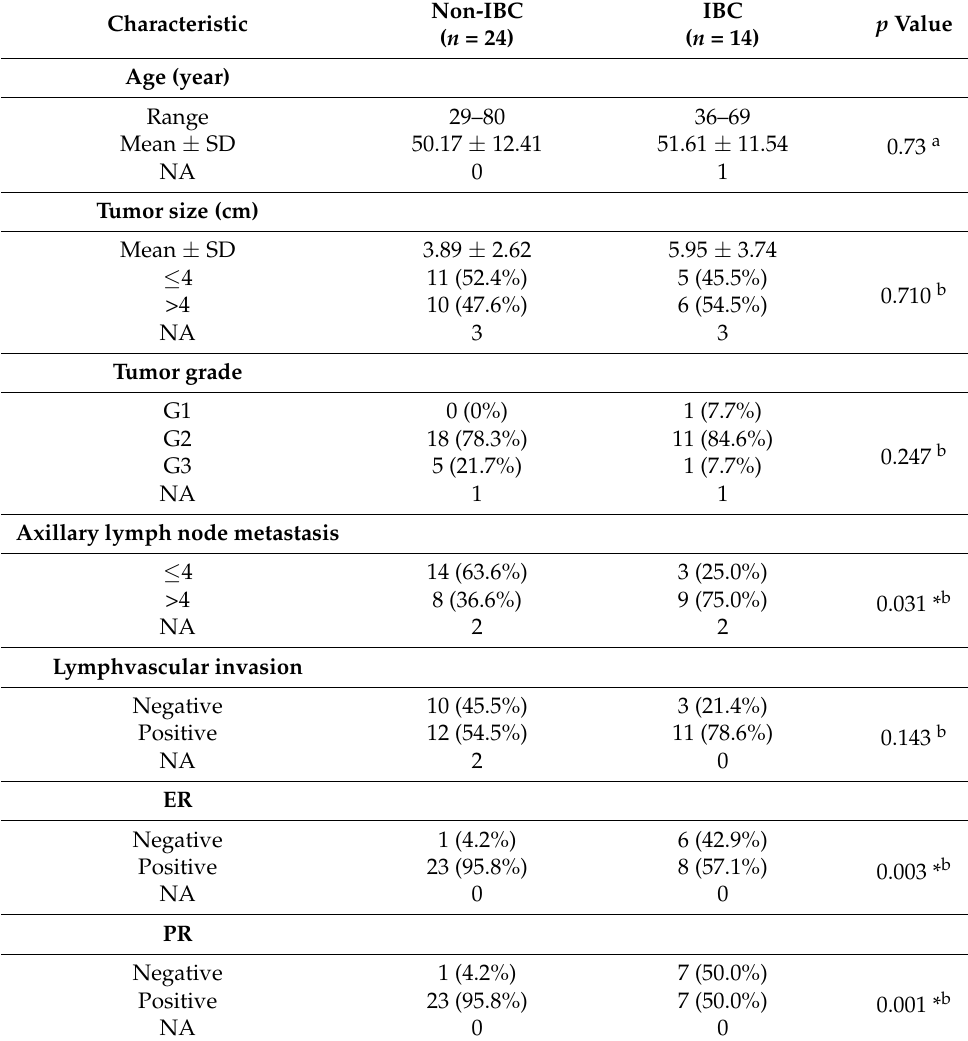
Table 1. Clinical and pathological characterization of non-IBC versus IBC patients.